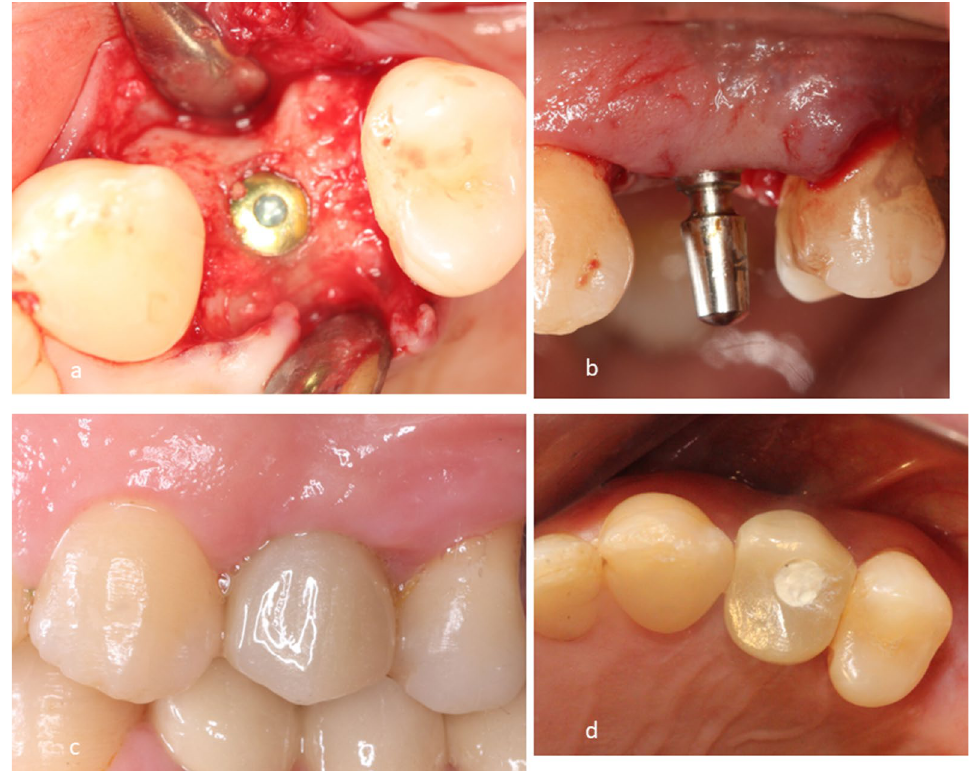
Fig. 2 Control group A : Implant Placement, B : Paralleling Pin, C : Final crown delivery, D : Occlusal view of the final